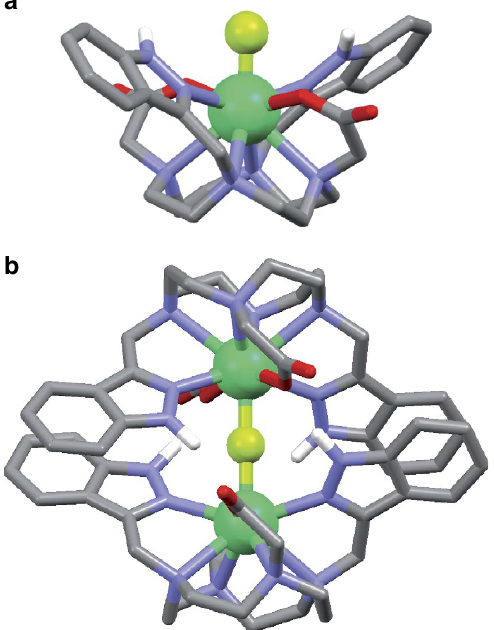
[(ErL) 2 F] þ dimer (Fig. 5). DFT calculations performed at the M06/LCRECP/6-31G(d,p) level provided an optimized structure